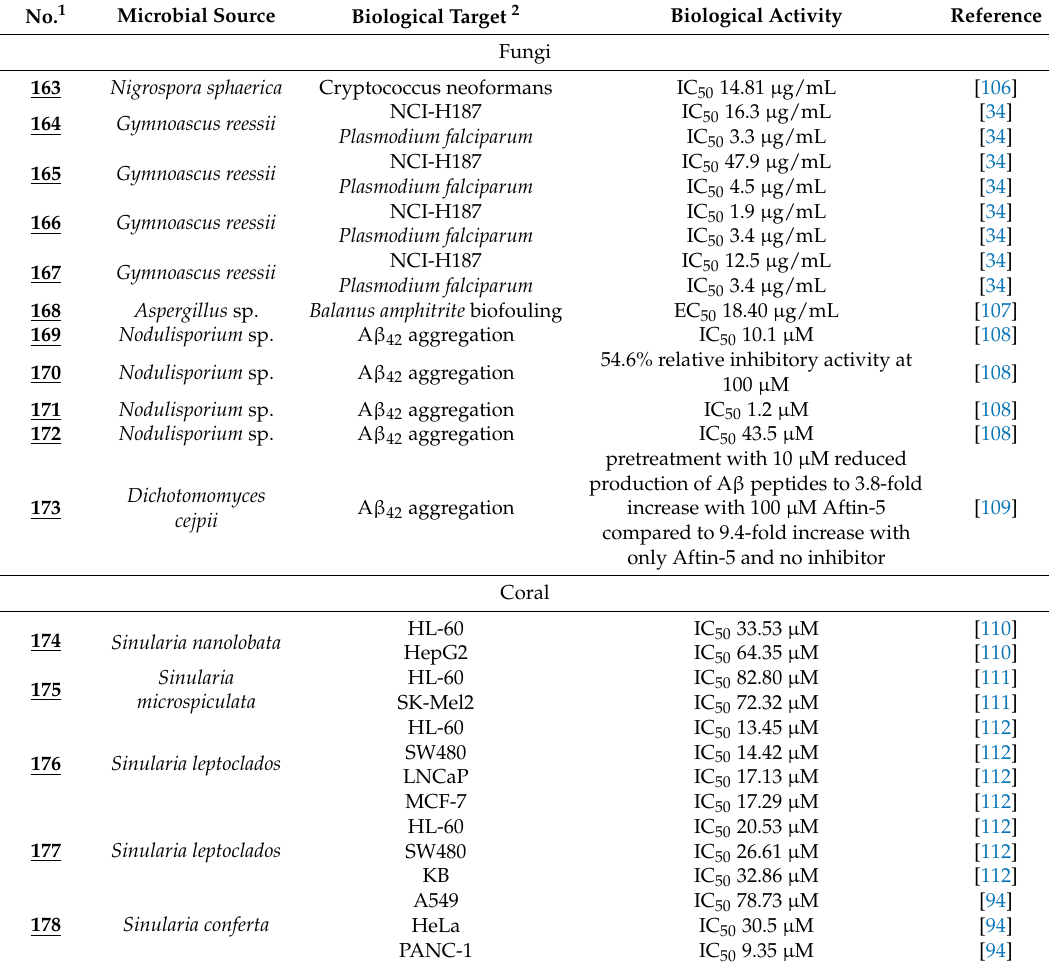
Table 2. Recently reported biological activities from microbial